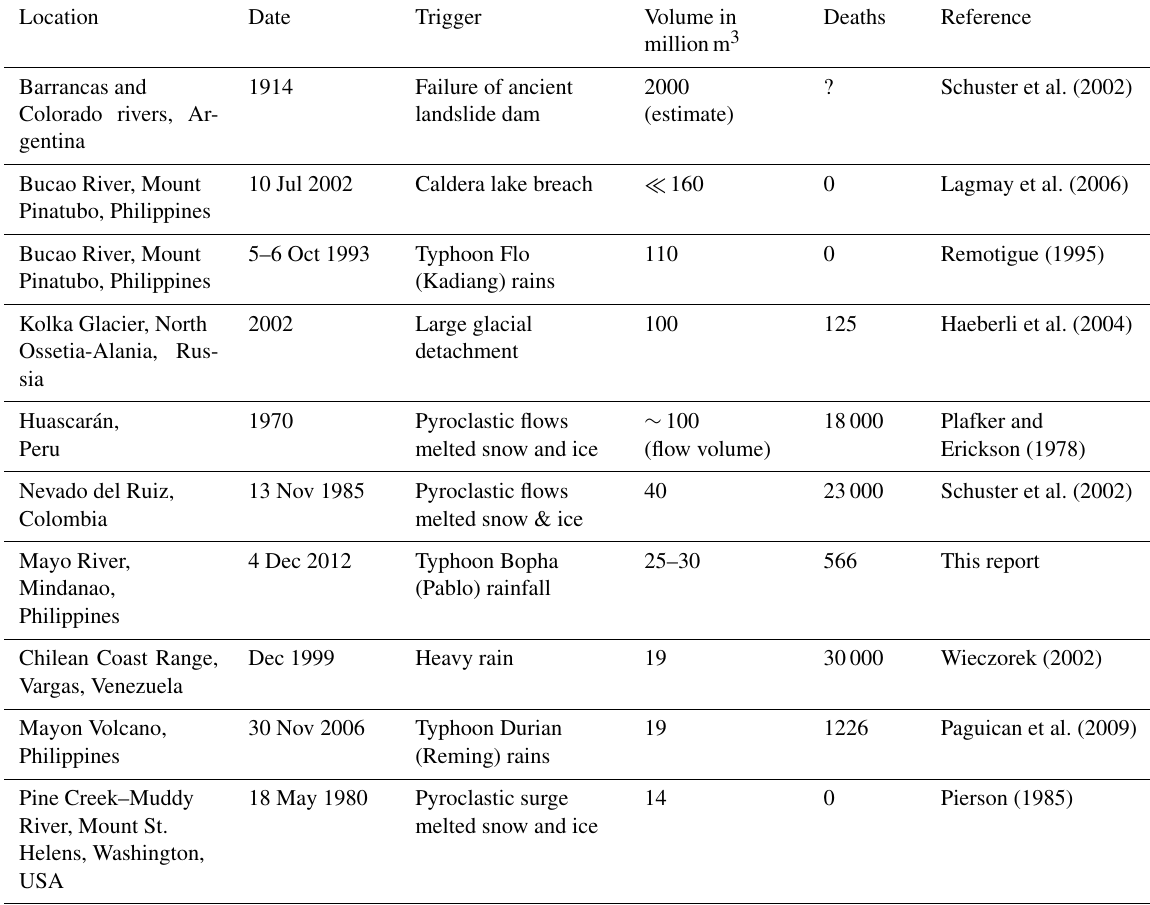
Table 1. The world’s 10 largest debris flows on record ranked by volume.